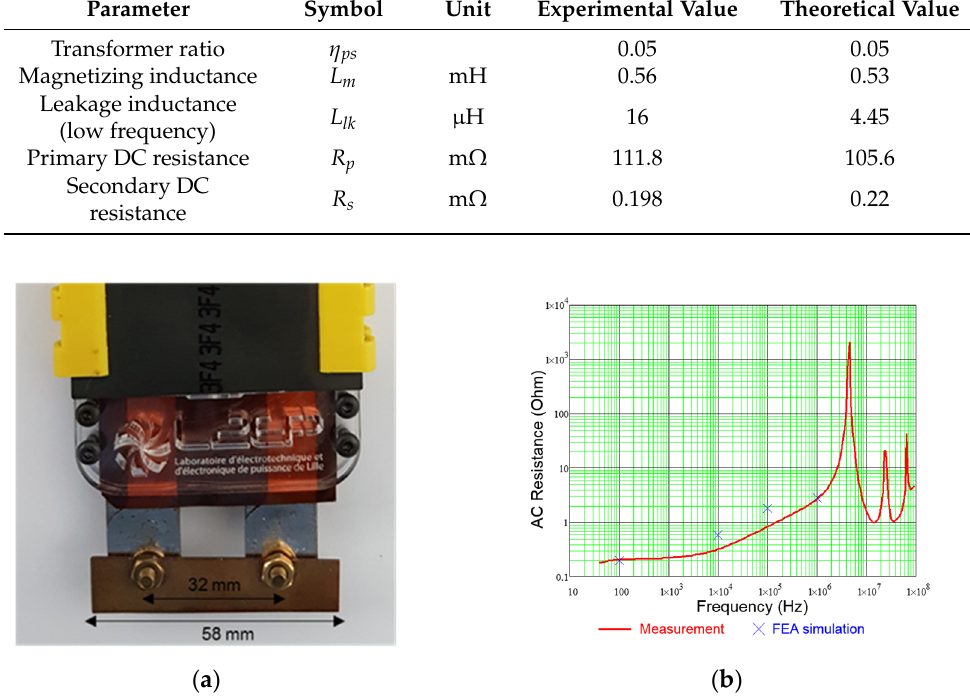
Figure 10. Planar transformer characterization: ( a ) short-circuit. ( b ) alternating current (AC) resistance vs. frequency.